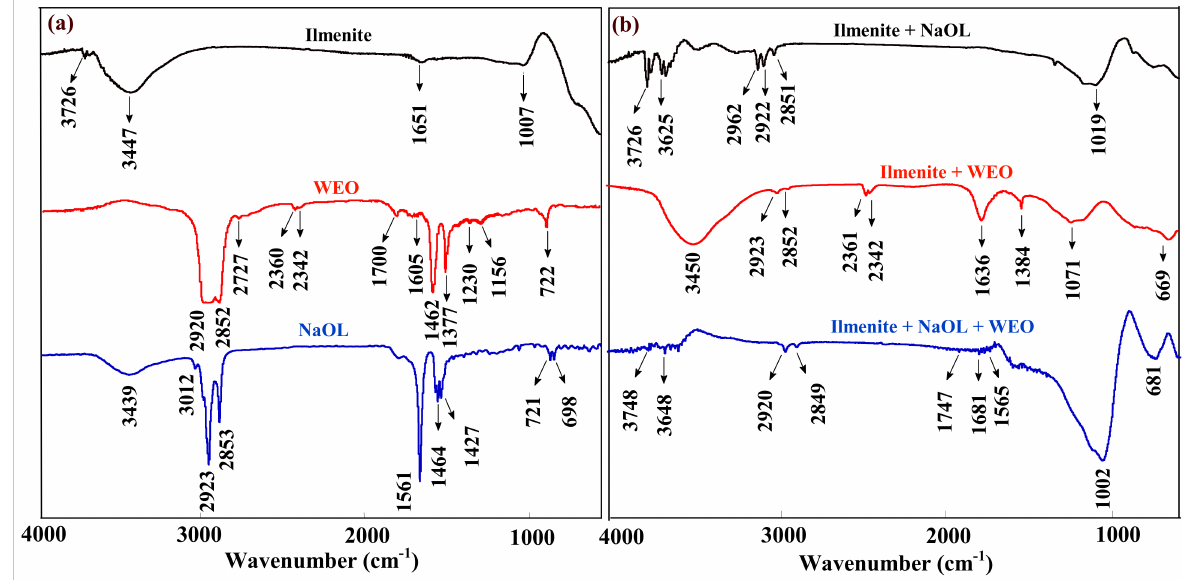
Figure 4. FTIR spectra of ( a ) ilmenite, WEO, and NaOL, and ( b ) ilmenite treated with WEO or/and